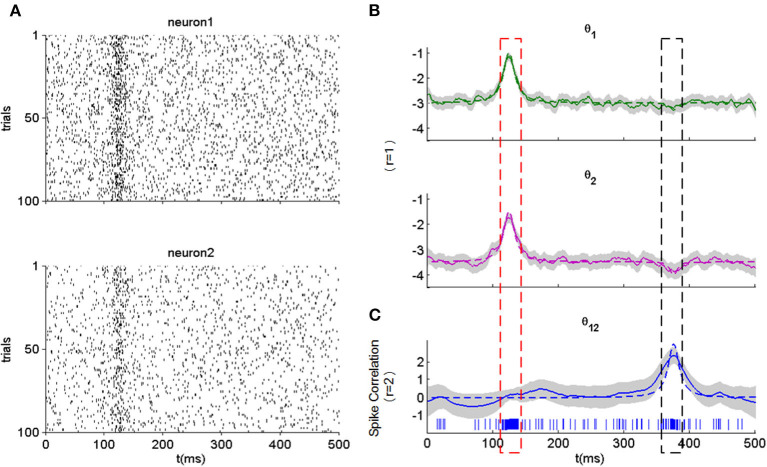
Estimation of spike correlations for simulation data of two neurons. (A) Simulated ensemble spike activities. The number of neurons is N = 2 and the number of trials is n = 100. (B) First-order spike correlations: true values (dashed lines) and their estimates (solid lines). (C) Second-order spike correlations: true value (dashed line) and its estimate (solid line). Blue raster, at the bottom, represent the synchronous spikes of the two neurons.